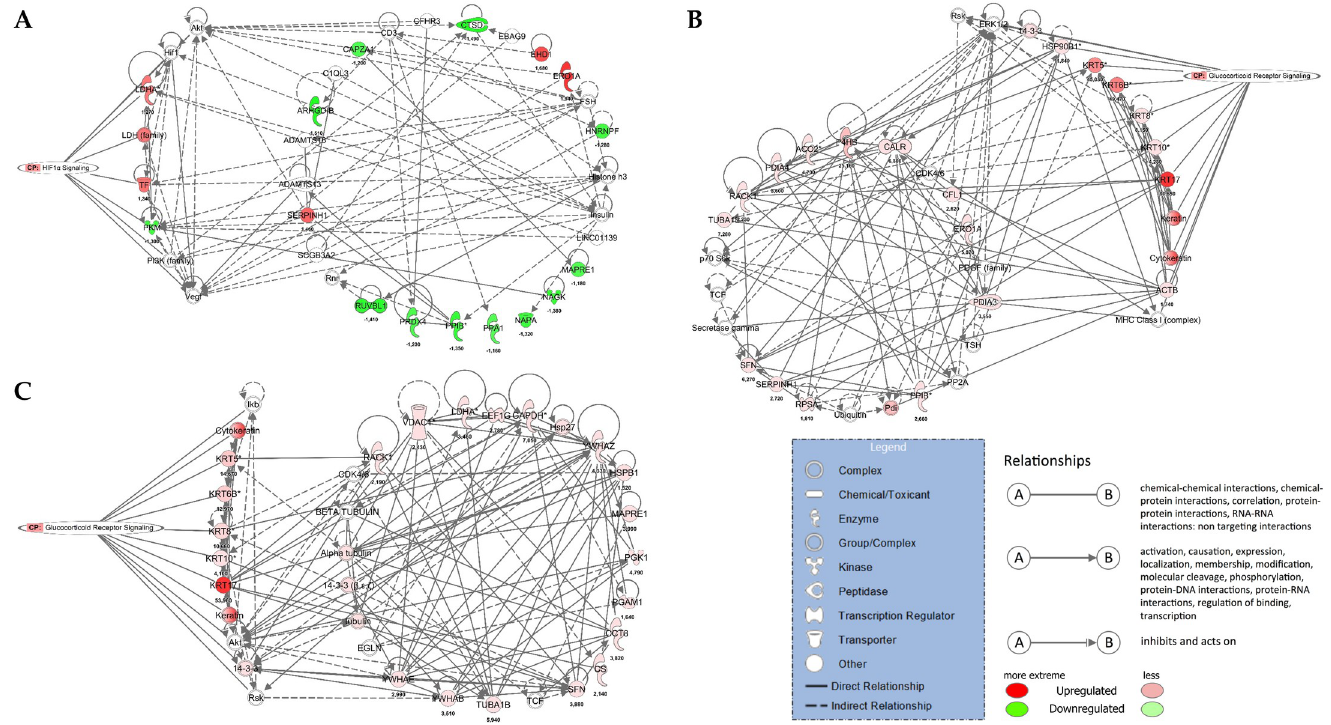
Fig 7. IPA networks for SCC. (A) center vs. margin comparison in SCC. Connective tissue disorders, post-translational modification, protein folding is presented together with HIF 1 α signaling canonical pathway; (B) center vs. control comparison in SCC. Cell morphology, embryonic development, hair and skin development and function is presented together with glucocorticoid receptor signaling canonical pathway and (C) margin vs. control comparison in SCC. Cell morphology, embryonic development, hair and skin development and function is presented together with glucocorticoid receptor signaling canonical pathway.